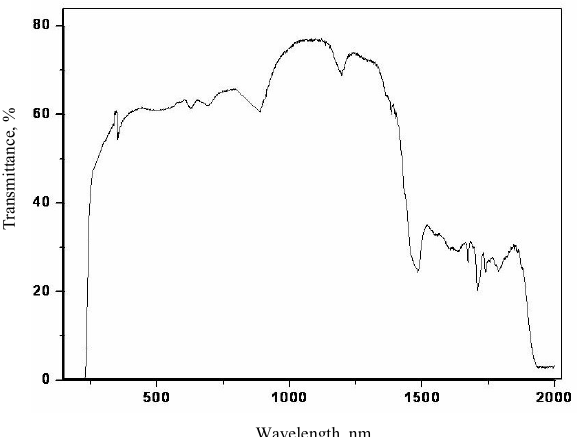
Figure 4. Optical transmission spectrum of